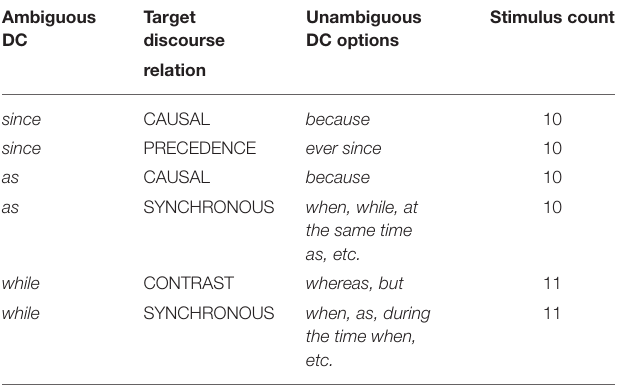
TABLE 2 | Summary of the stimuli. Ambiguous